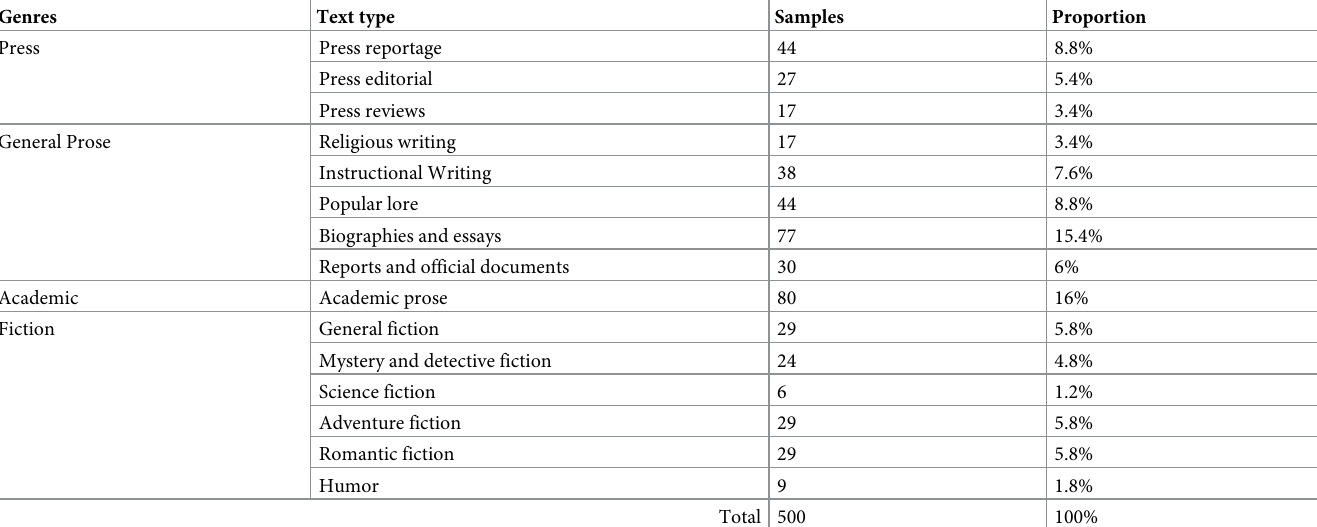
Table 1. Genres and Text types in LCMC and